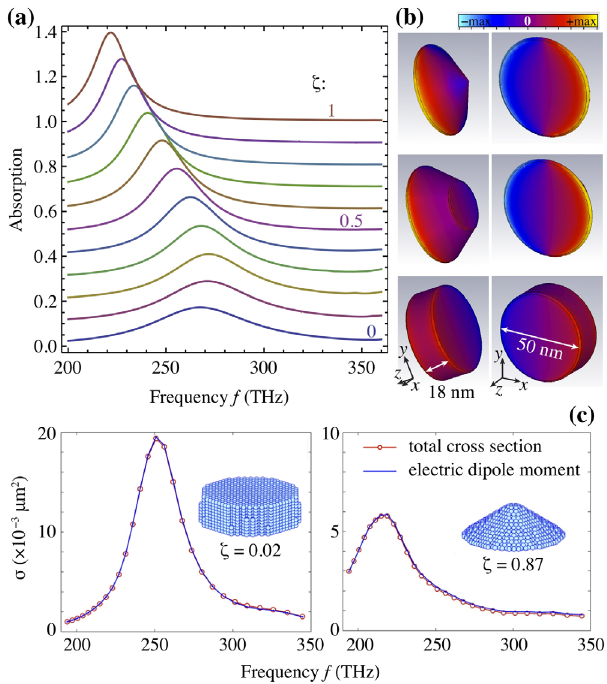
FIG. 2. (a) Absorption spectra for the nanoparticle lattice with the conicity parameter ζ ranging from 0 (cylinders) to 1 (cones). The light is normally incident onto the lattice plane and linearly polarized along the x axis. For easier readability, each line is offset by 0.1. (b) Images of the normal component of the electric field at the plasmonic resonance (the frequency of the absorption maximum) for ζ ¼ 0 , 0.5, and 1, viewed from two different angles.(c) Extinction cross section for a single nanoparticle with near-cylindrical ( ζ ¼ 0 . 02 ) and highly conical ( ζ ¼ 0 . 87 ) shape, calculated with the DDA method comparing the full cross section (dots) with the electric dipole moment contribution (blue line); the insets show the images of the discretized